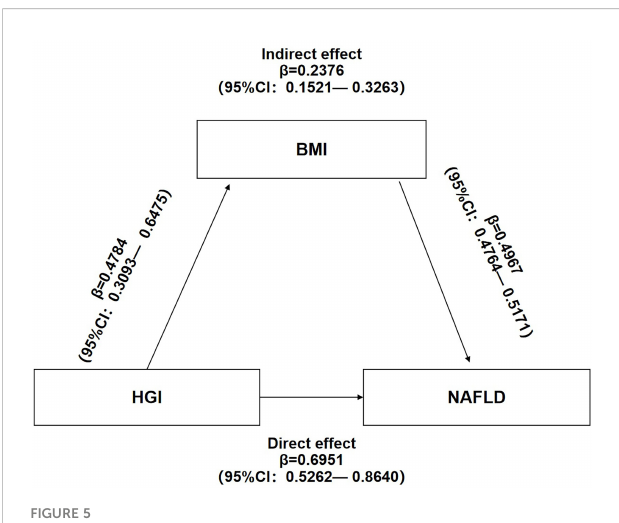
FIGURE 5 Mediation of BMI on the association between HGI and NAFLD.